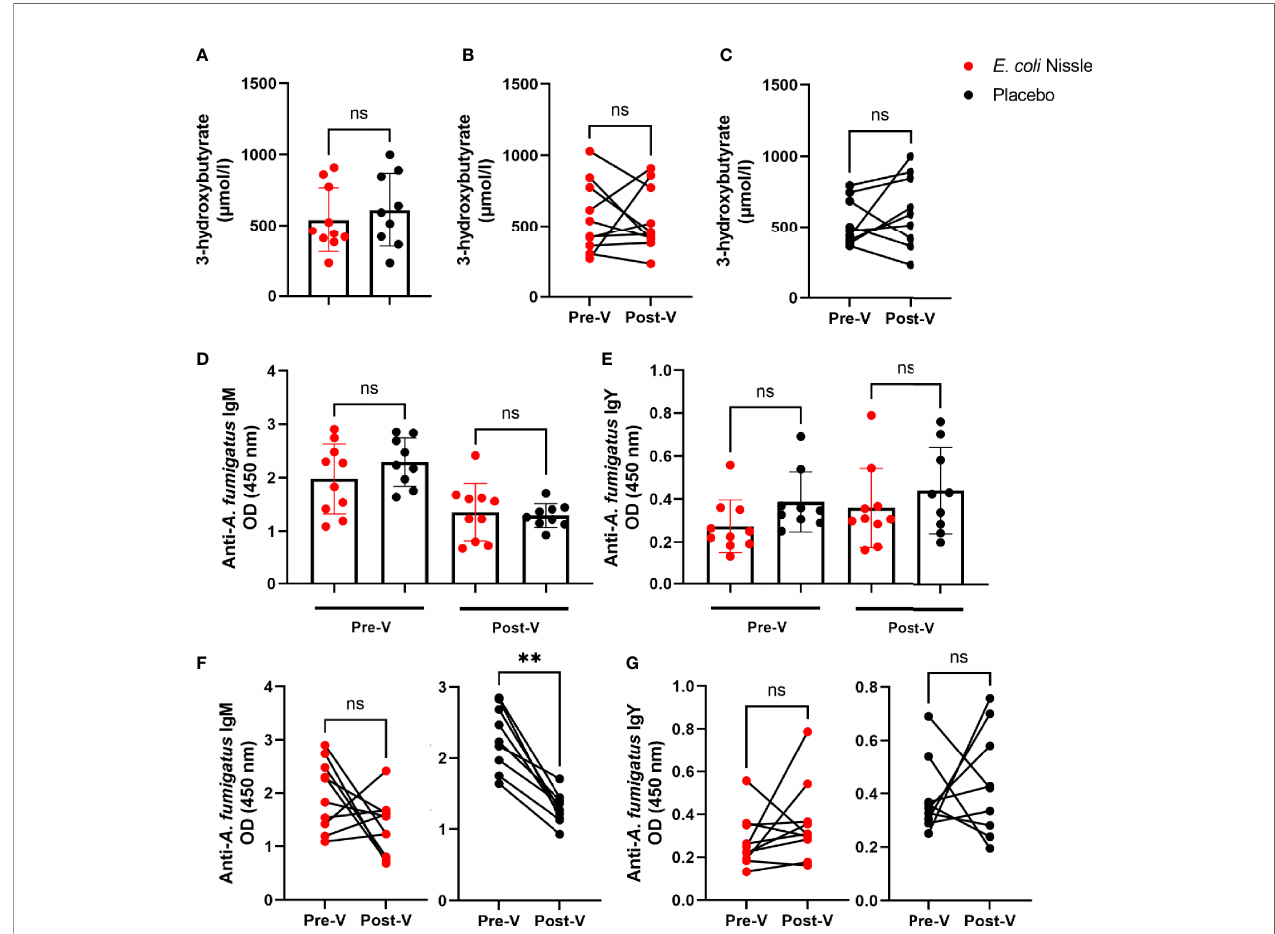
FIGURE 6 | 3-OHB plasma levels and anti- A. fumigatus Abs after oral administration of E coli Nissle. The concentration of 3-OHB (µmol/L) in the E coli Nissle (red dots) and placebo (black dots) groups were compared between groups (A) and within E coli Nissle (B) or placebo (C) groups before (Pre-V) and after (Post-V) the vaccination protocol. Anti- A. fumigatus IgM (D, F) and IgY (E, G) levels in penguin sera were measured by indirect ELISA and compared between (D, E) and within (F, G) groups. Individual (A – G) and means and standard deviation (A, D, E) values are shown. Values were compared by paired (B, C, F, G) or unpaired (A, D, E) student ’ s t -test (** p < 0.005; ns, not signi fi cant, 1 experiment, n = 10 in the E coli Nissle group and n = 9 in the placebo group, and three technical replicates per sample in the